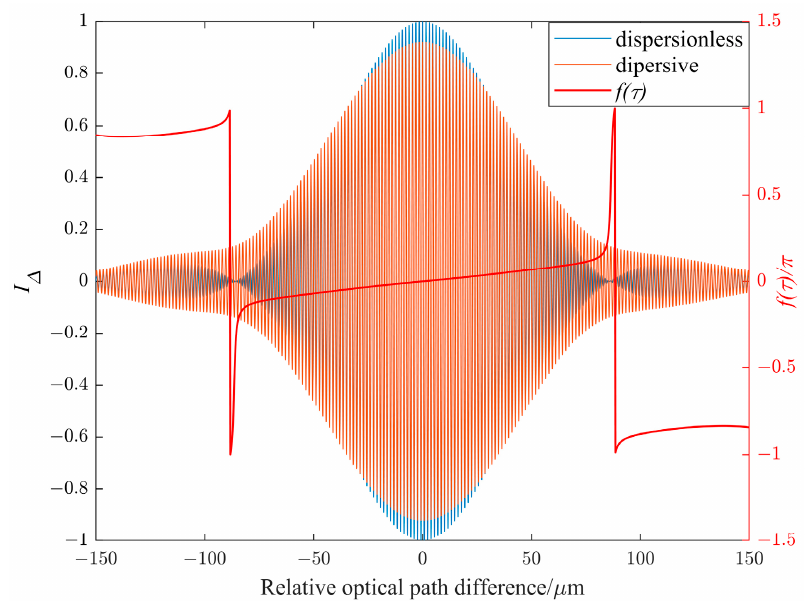
Figure 8. Measured interference term I ∆ .